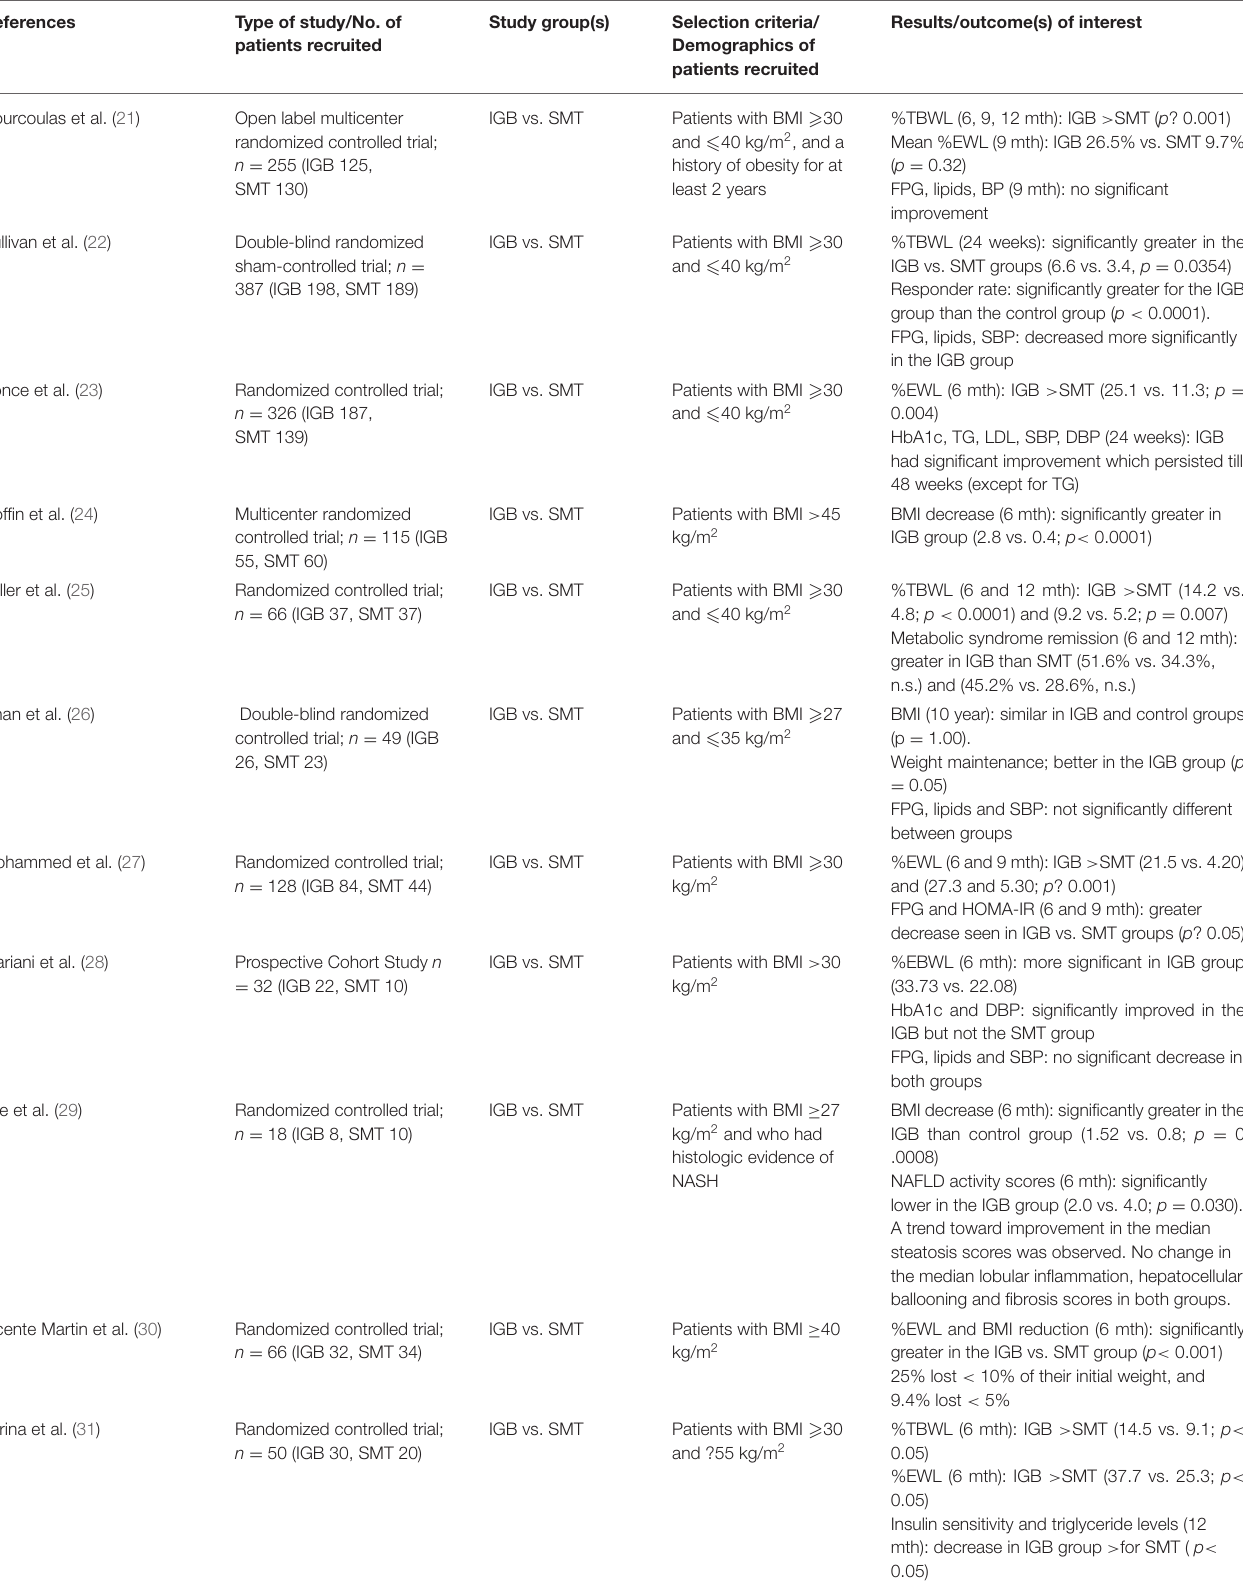
TABLE 3 | Studies included for the study of IGB on Metabolic Syndrome and related comorbidities in